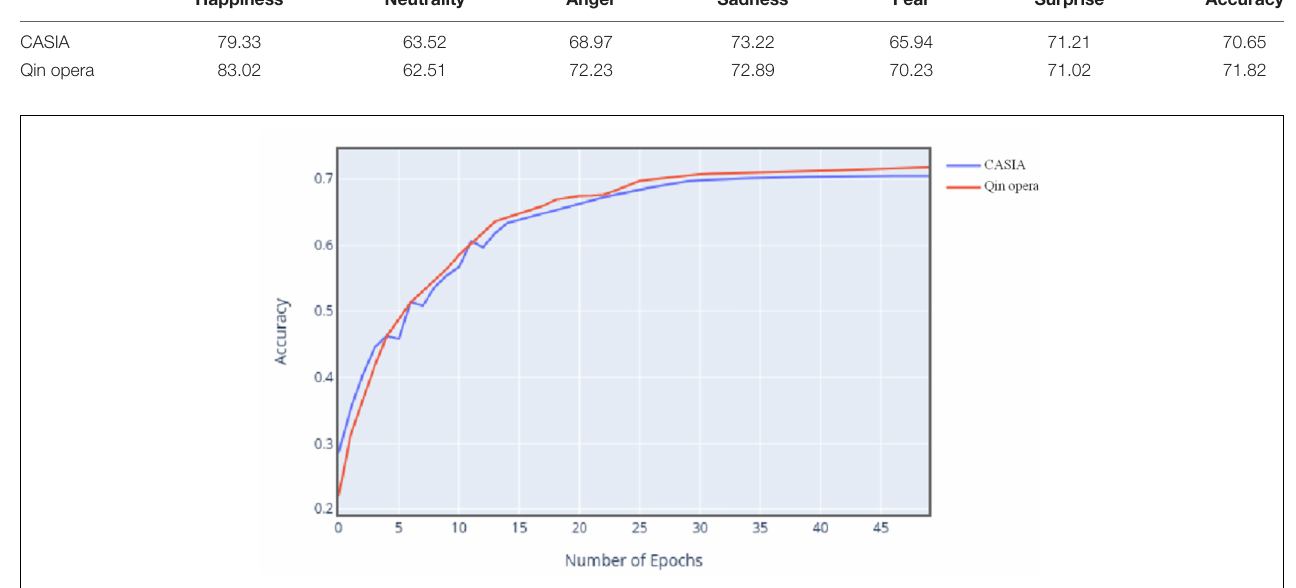
FIGURE 8 | Change curve of classification accuracy of two data